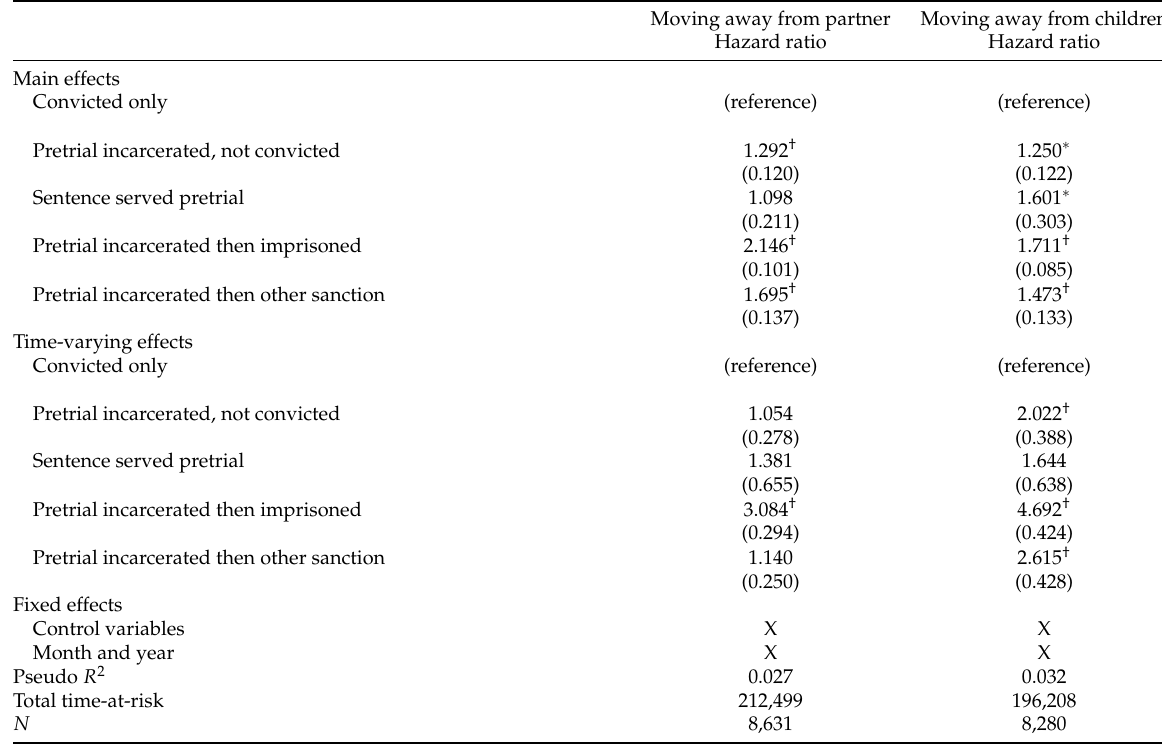
Table 3: Results from Cox proportional hazards models analyzing the risk of moving away from partner or children after release among those living with a partner or their children at admission. Men, Denmark, 1995 to